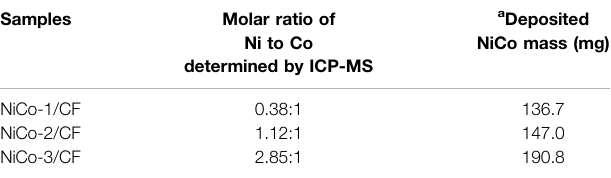
TABLE 1 | The molar ratios and deposited NiCo mass of three